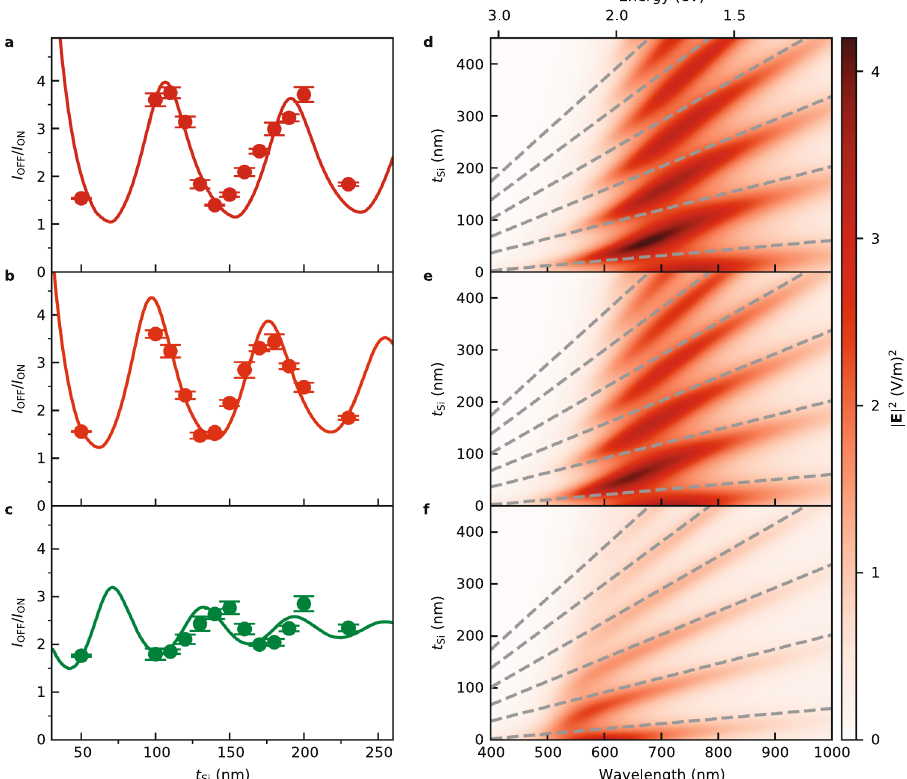
Fig. 2 Enhancement of detection and coupling to FP modes. a – c Ratio of the OFF resonance current (at the fi xed angle of 25°) and the ON resonance current (at the SPR angle) as a function of silicon thickness for three photon wavelengths (670 nm, 635 nm, 532 nm, respectively) with gold thickness of 30 nm. Symbols with error bars are the mean and SD of four samples. Solid lines are the simulated results with numbers indicating the cavity modes. d – f Simulated near fi eld electric fi eld intensity at the gold/air interface as a function of silicon layer thickness and wavelength (photon energy) at 28.1°, 28.5°, and 31.1°, respectively. Dashed lines are linear best fi ts to the FP modes in the absence of SPR. Source data are provided as a Source Data fi